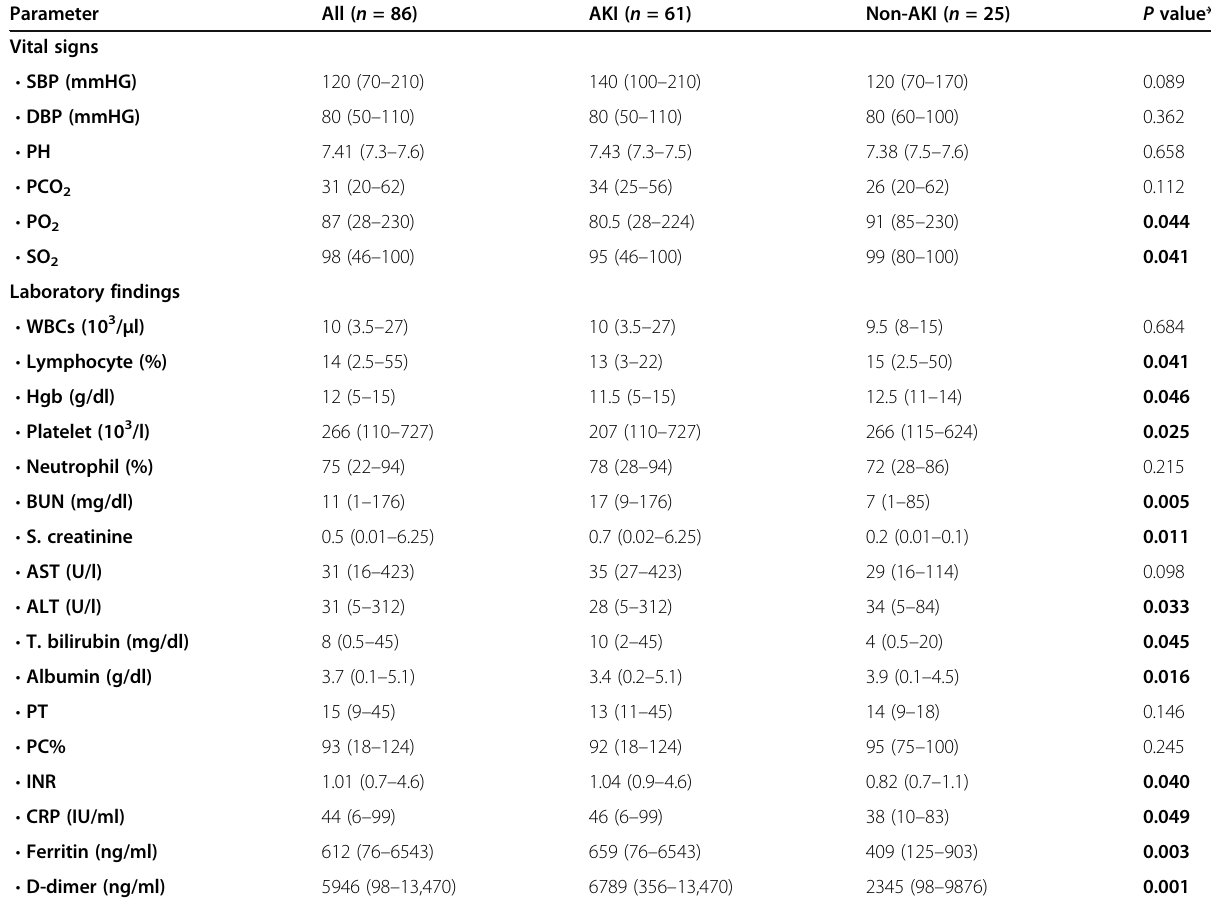
Table 3 Vital signs and lab. differences among the studied COVID-19 patients